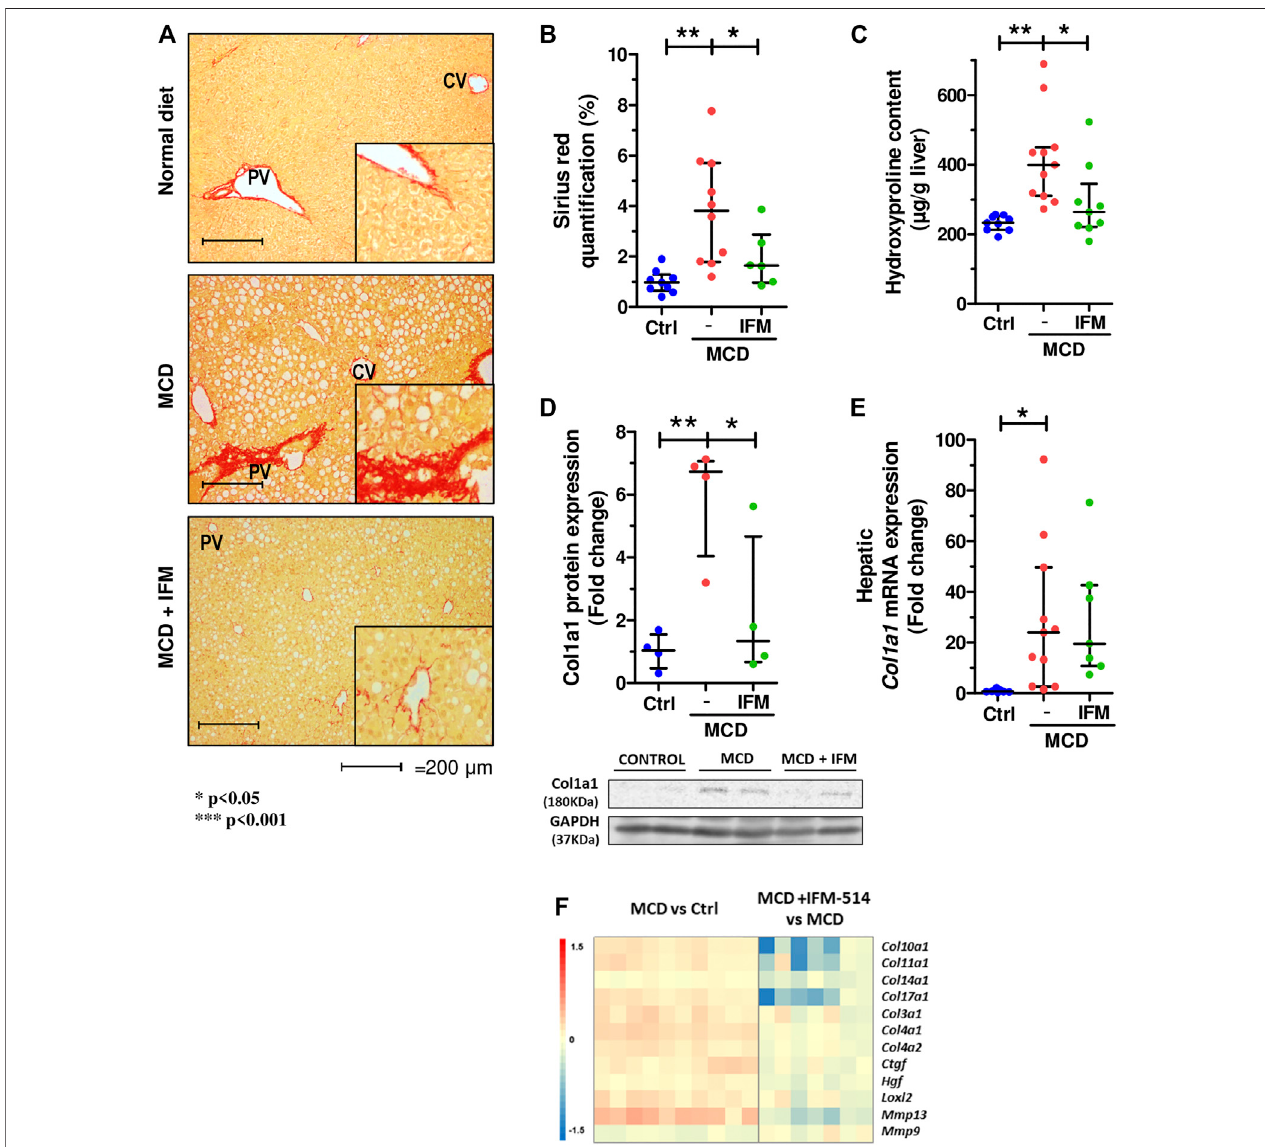
FIGURE4| IFM-514reducesliver fi brosisinMCD-fed ApoE -/- mice.Siriusred(SR)staining (A) withSRquanti fi cation (B) andhepatic4-hydroxyprolinecontent (C) . HepaticCol1a1protein (D) andmRNAexpression (E) fromIFM-514-treatedMCD-fed ApoE -/- mice.Heatmapforhepatic fi brosissetofgenes (F). Resultsareexpressed as mean ± standard error of the mean (SEM); n (cid:1) 10/group, # p < 0.1, * p < 0.05, ** p < 0.01 and *** p < 0.001. $ p < 0.05, if outliers are excluded. Scale bars (cid:1) 200 μ m. Abbreviations: col1a1, collagen type 1 α 1. See Supplementary Table 3 for Heatmap genes.